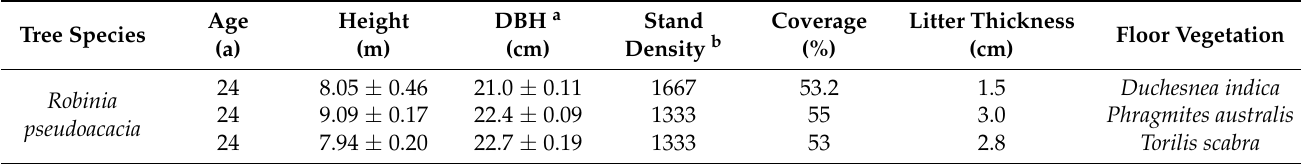
Figure 1. Geographic locations of the study area and sampling site. The black empty circles are the soil bulk density and soil particle composition sampling points. The red empty circles are the root density sampling points. Table 1. The elemental information for the sample plots. Floor Vegetation Robinia